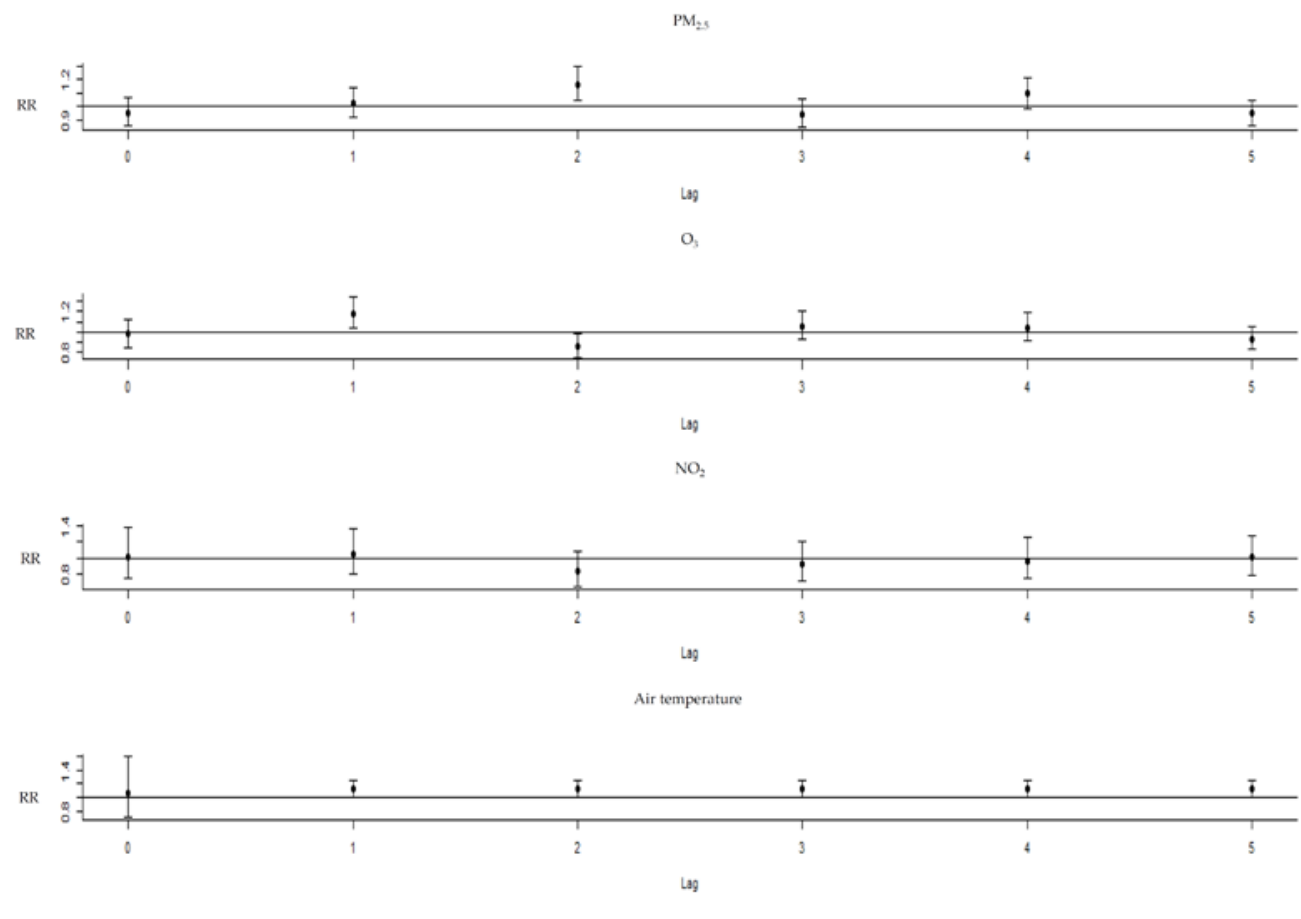
Figure 3. The relative risks of PM 2.5 , ozone and NO 2 with the thresholds increased every 10 units, and air temperature compared with the temperature of minimum asthma emergency room visits.